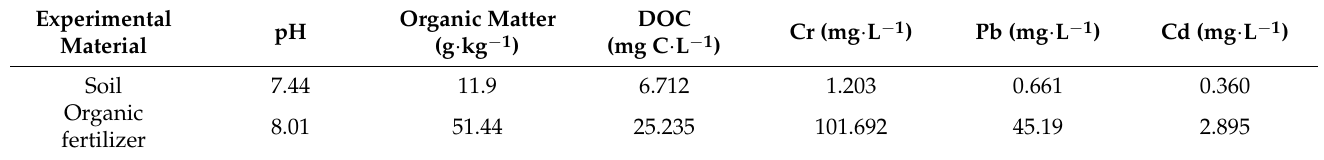
Table 1. Basic physical and chemical properties of soil and organic